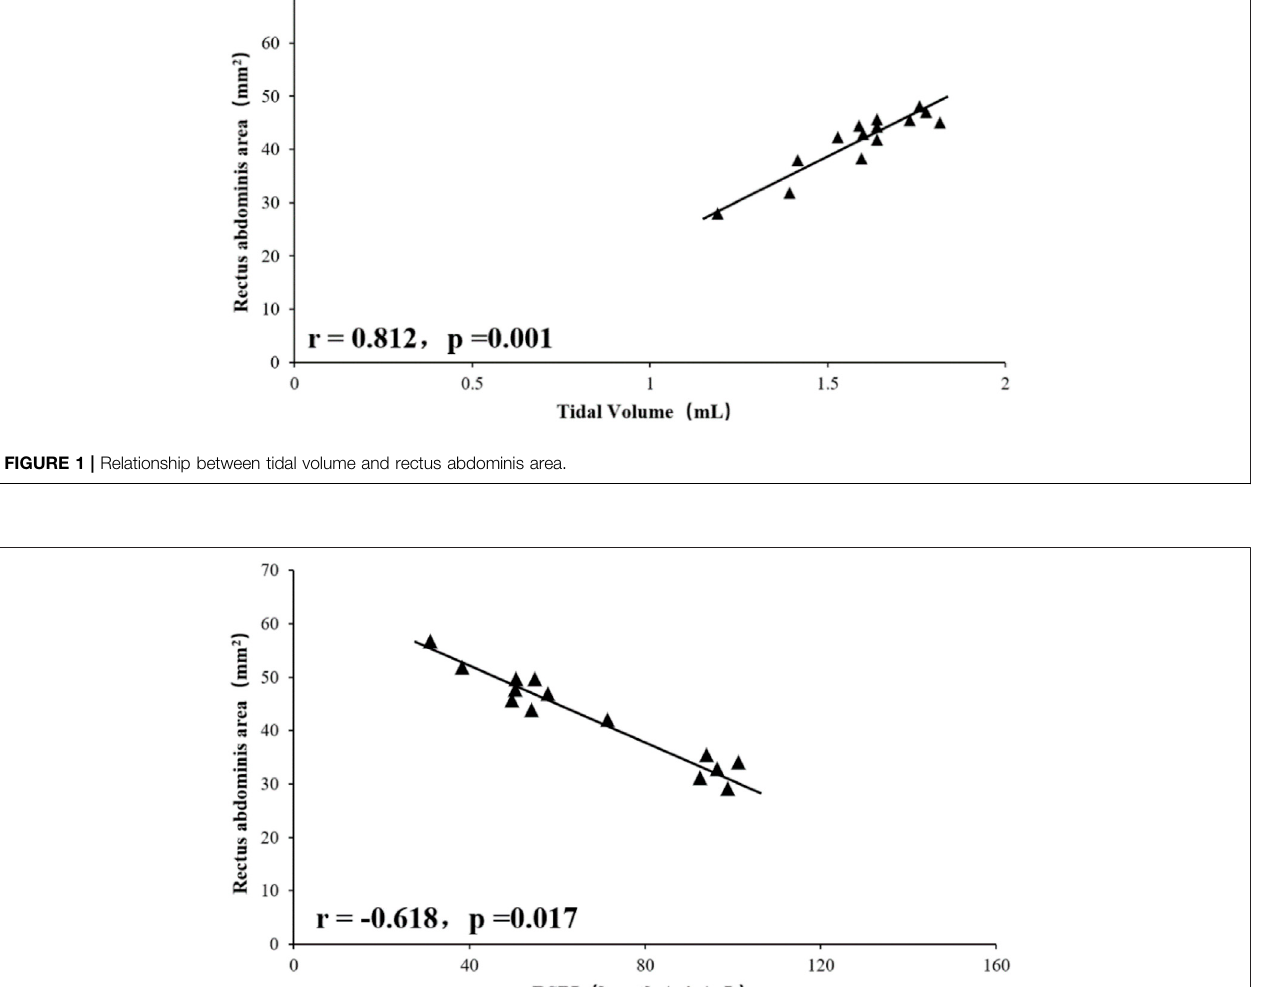
FIGURE 2 | Relationship between BRSBI and rectus abdominis